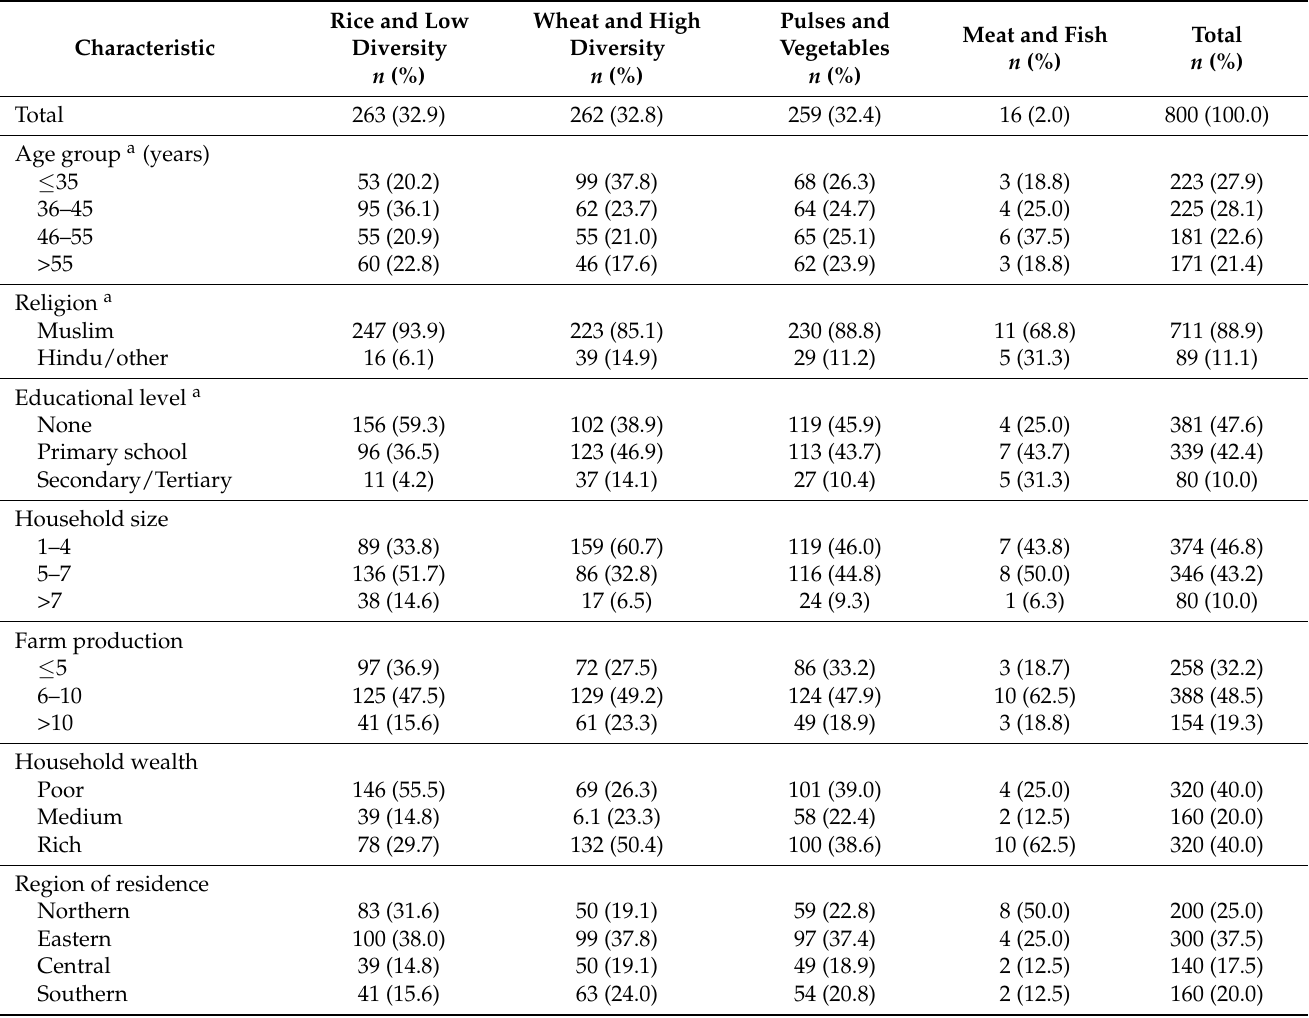
Table 1. Distribution of socio-demographic characteristics of households by dietary pattern in Bangladesh. Rice and Low Wheat and High Characteristic Diversity